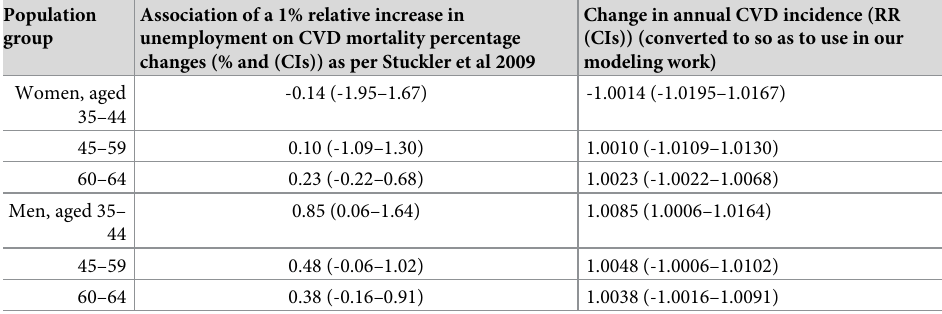
Table 2. Associations between unemployment and CVD incidence used in this modeling study adapted from the literature (Stuckler et al 2009 [10]). Population